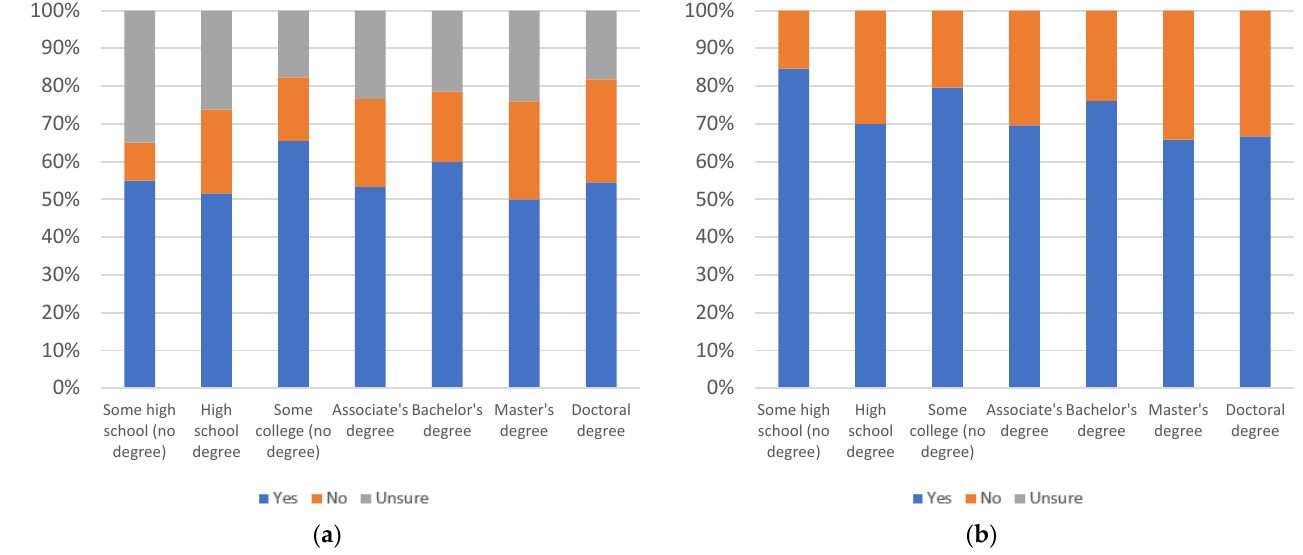
Figure 63. Label others’ use, by education level: ( a ) with uncertain respondents (left) and ( b ) without uncertain respondents (right).